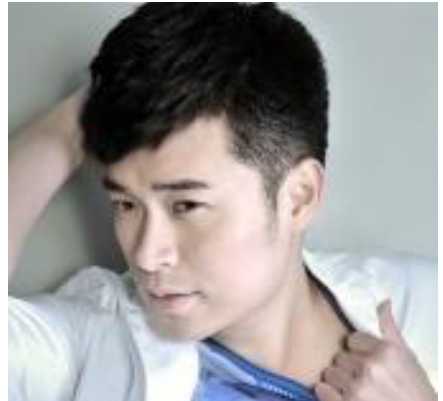
Figure 3. An unmasked image from the RMFRD